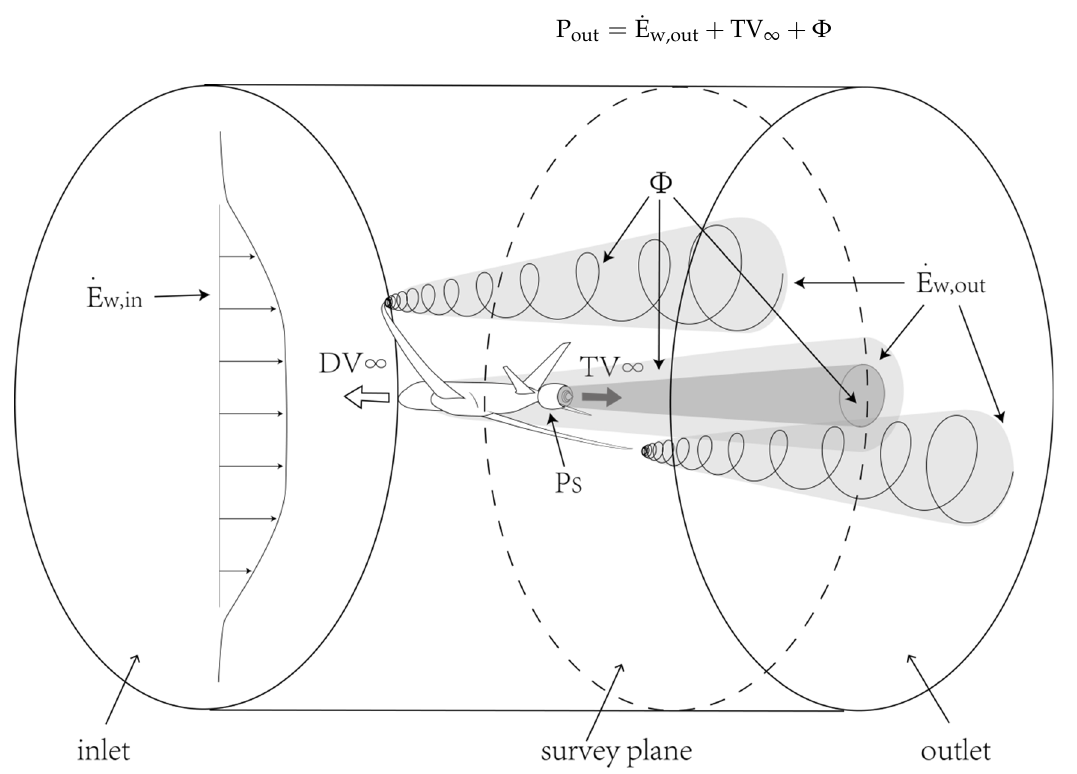
Figure 3. Control volume of a simplified aircraft with a BLI propulsor. Table 1. Power terms in the control volume of an aircraft.